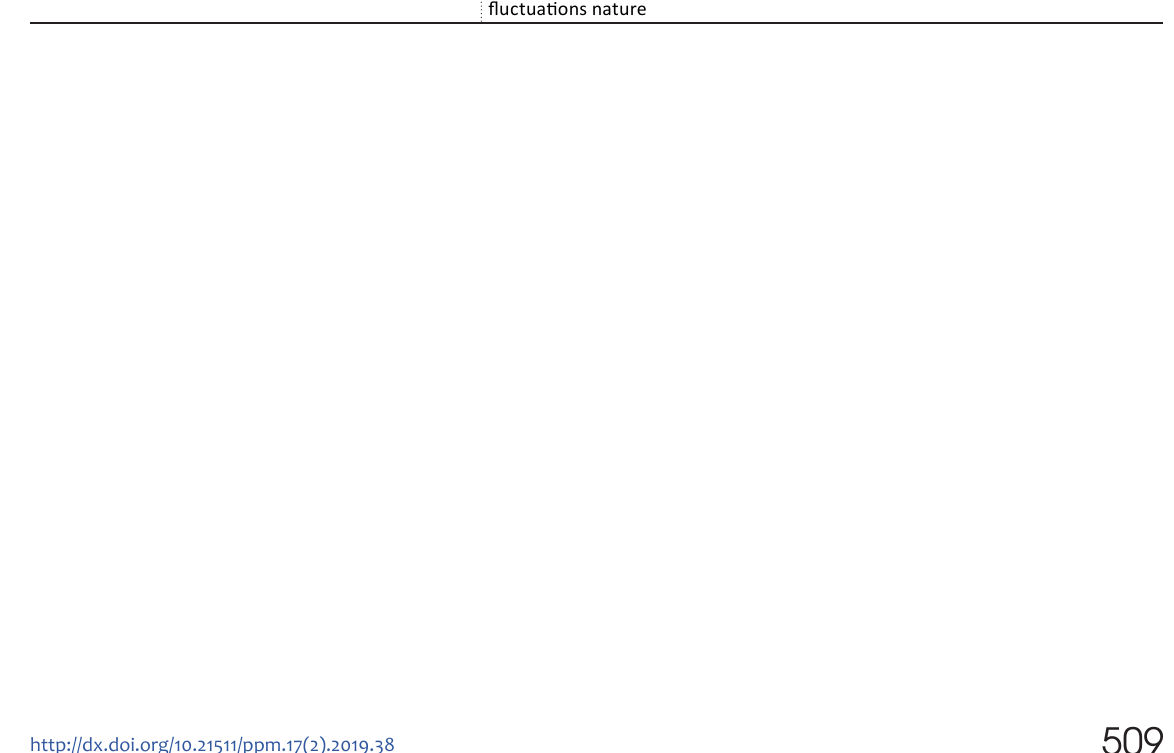
Table A1. Methods to estimate the potential GDP and GDP breakdowns